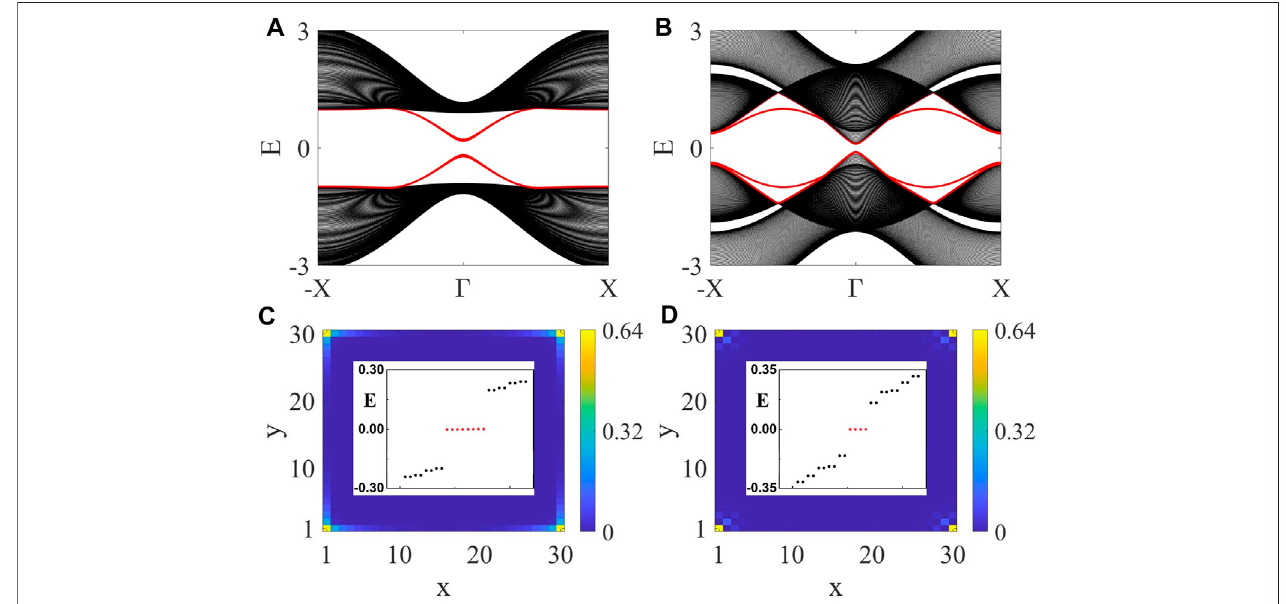
FIGURE6| (Coloronline)Bulktopologicalphasetransitionsinducedbyanout-of-planeantiferromagnetic-typeZeeman fi eld.Chosenparametersare: t =1, m =1, λ = 1, η = 0.2. For the chosen set of parameters, B < B fi les of the middle eight eigenstates and their c , Γ = 1. In (A) and (C) , B z = 0.1 c , Γ . The probability density pro eigenvalues(reddots)showthattheeightzero-energycornerstatesarerobustintheweak- fi eldregime.In (B) and (D) , B z =1.1 > B c , Γ .Thenumberofzero-energycorner states indicates that the system enters a new SOTI phase with one bound state per corner. N y = 100 in (A) and (B) .